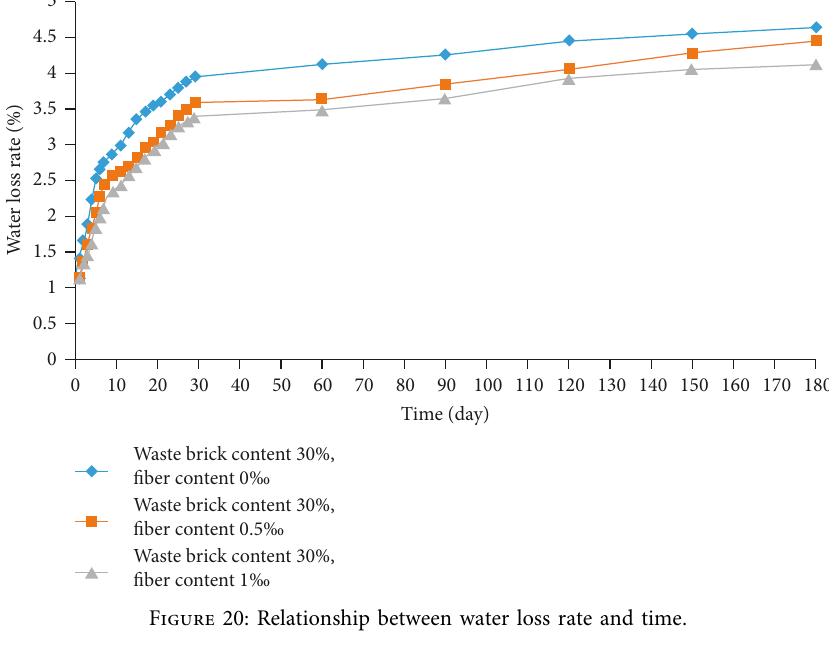
Figure 20: Relationship between water loss rate and time.